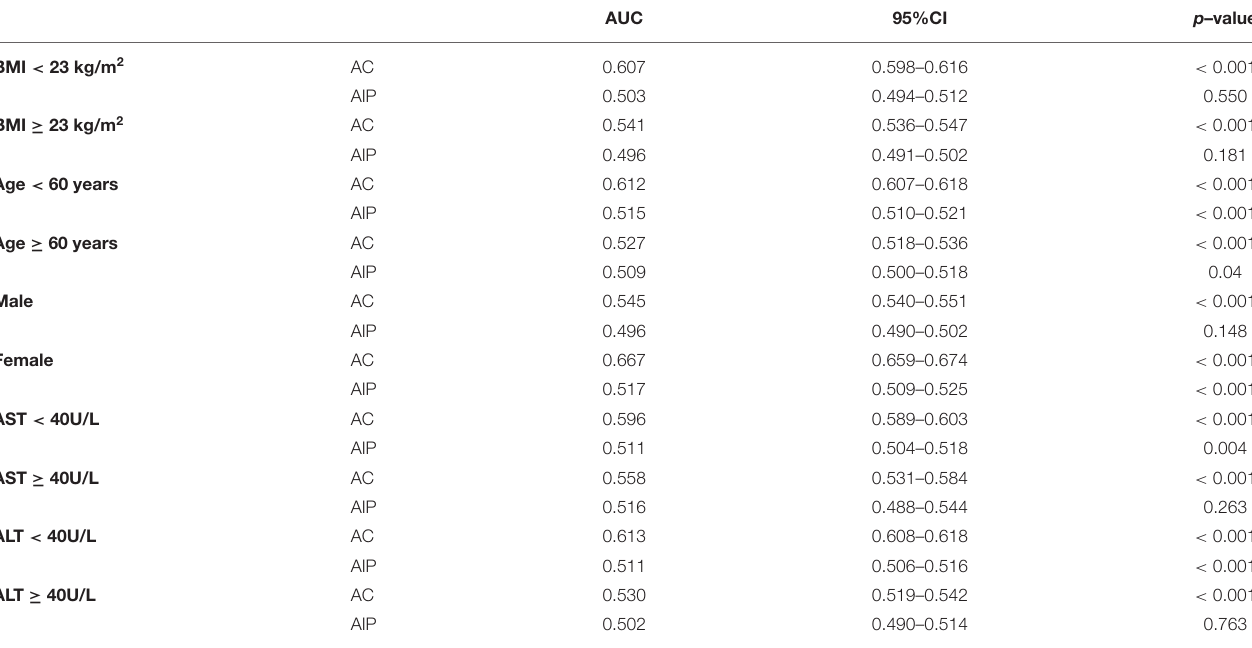
TABLE 4 | Predictive value of AC and AIP for the incidence of hypertension according to BMI, age, gender, AST and ALT.